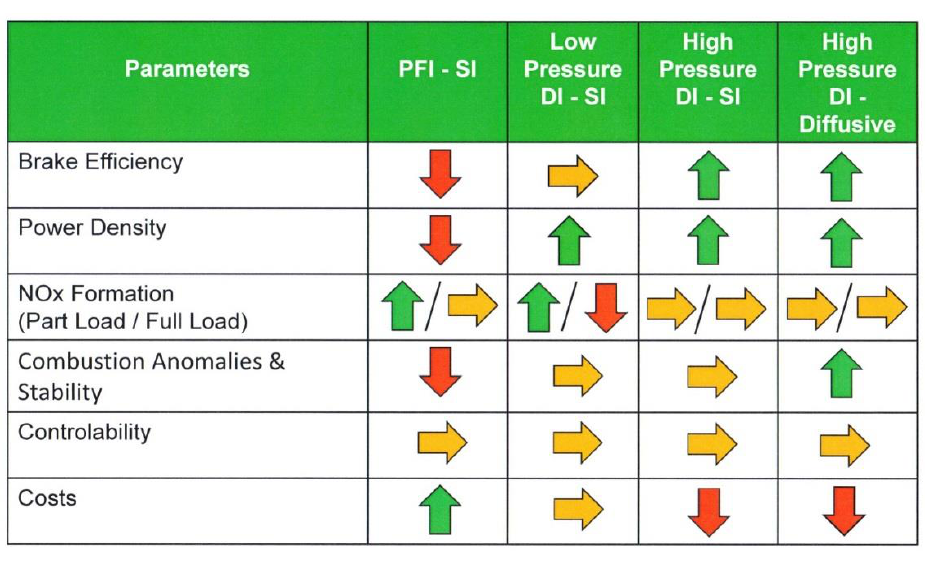
Figure 3. Comparison of different hydrogen combustion processes [120].